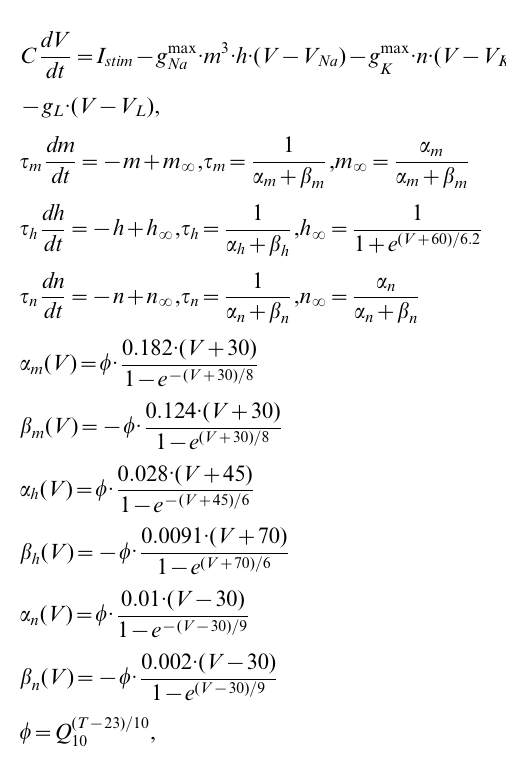
Figure S2 A–C. Phase plots of membrane potential V vs. Na + activation variable m (A), Na + inactivation variable h (B) and K + activation variable n (C) for temperature T = 18 u C, and 36 u C, respectively. Also plotted (black traces) are the steady state